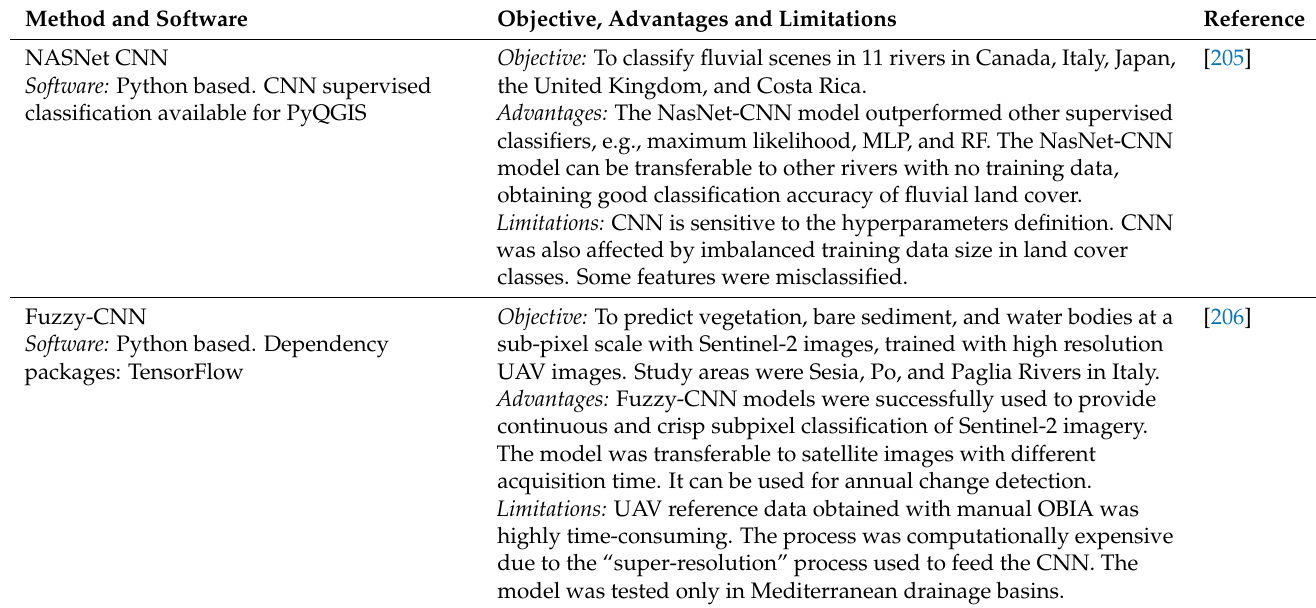
Table 5. Selected GeoAI applications in fluvial geomorphic and morphodynamic mapping. Objective, Advantages and